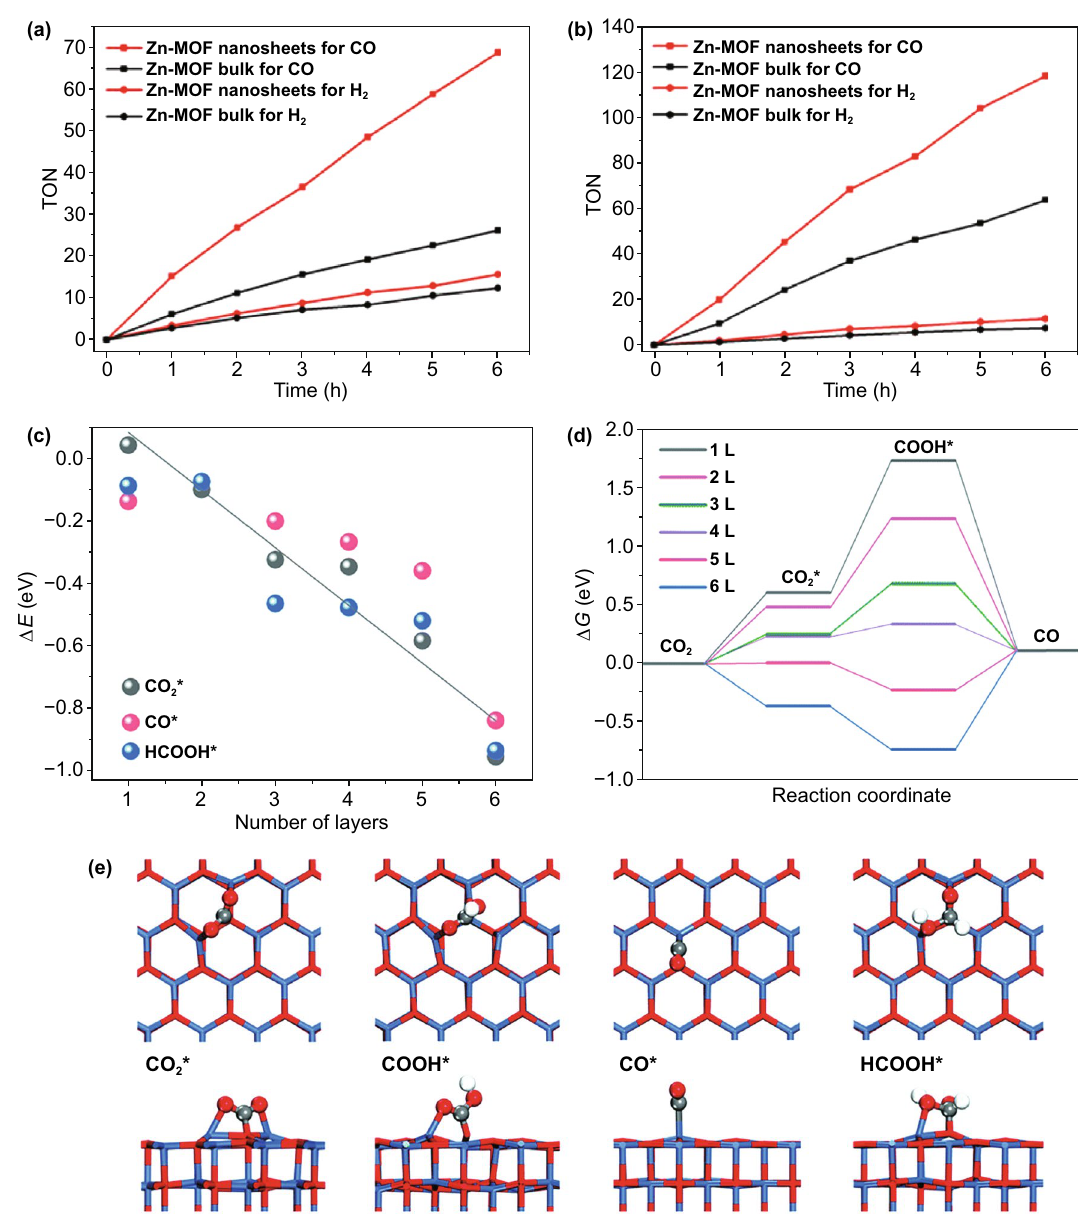
Fig. 11 2D nanomaterials for efficient photocatalytic CO 2 conversion systems. a, b Ultrathin 2D Zn-MOF nanosheets for photoreduction of CO 2 to CO. Reproduced with permission [350]. Copyright 2018, Elsevier. c‑e 2D ZnO nanomaterials for selective photoreduction of CO 2 . Repro- duced with permission [351]. Copyright 2019, Royal Society of